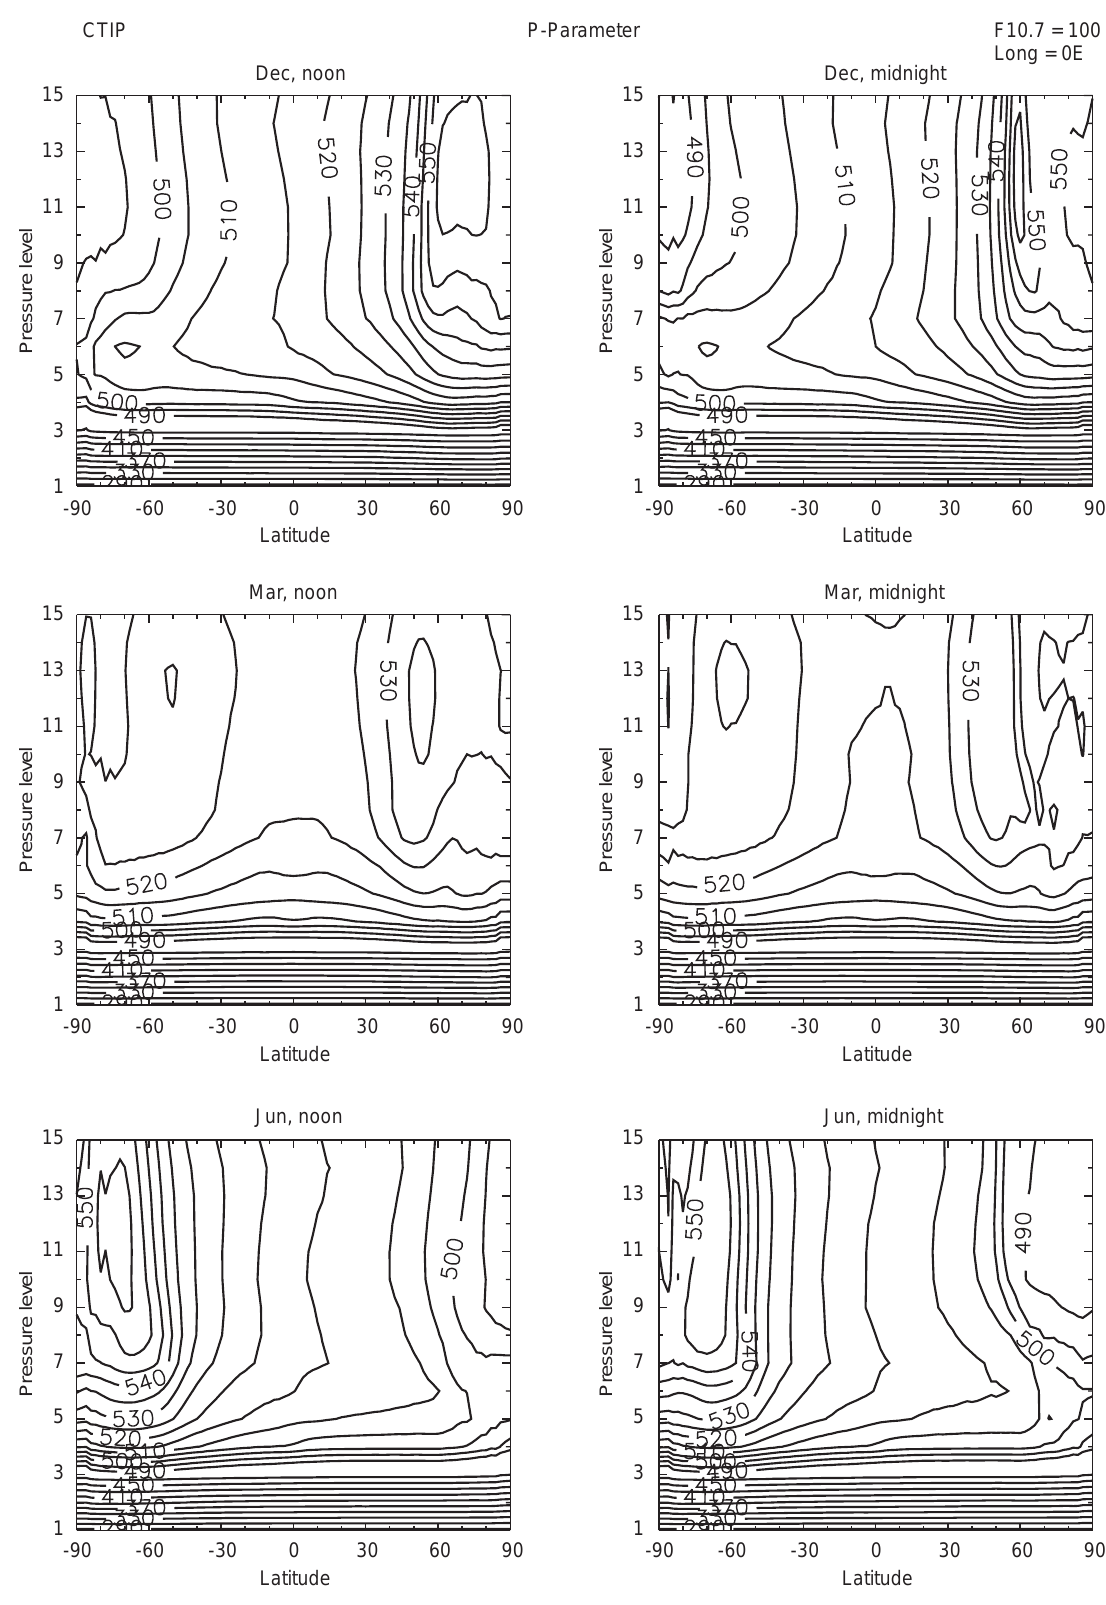
Fig. 4. Cross sections of P -parameter versus geographic latitude and pressure-level Z at local noon and midnight, longitude 0 (cid:14) , for December, March and June. See Table 1 for the relation between pressure-level Z and real height. Contour interval 5